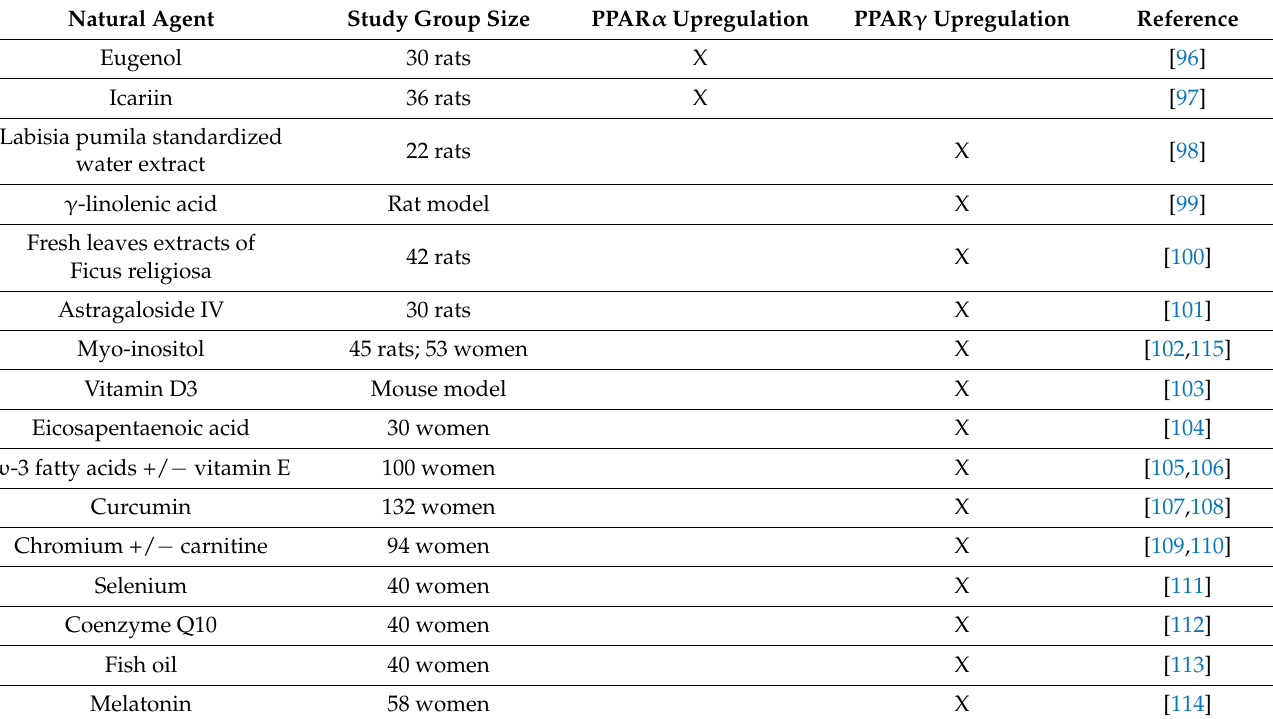
Table 3. The influence of natural agents on PPAR expression in